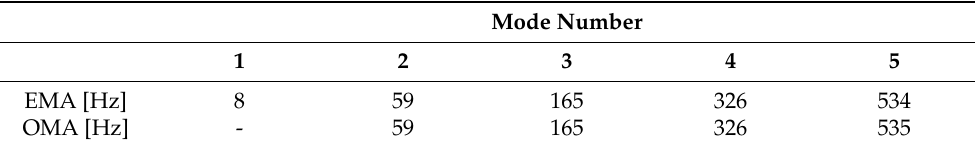
Table 1. Steel bar’s regenerate structure natural frequencies.